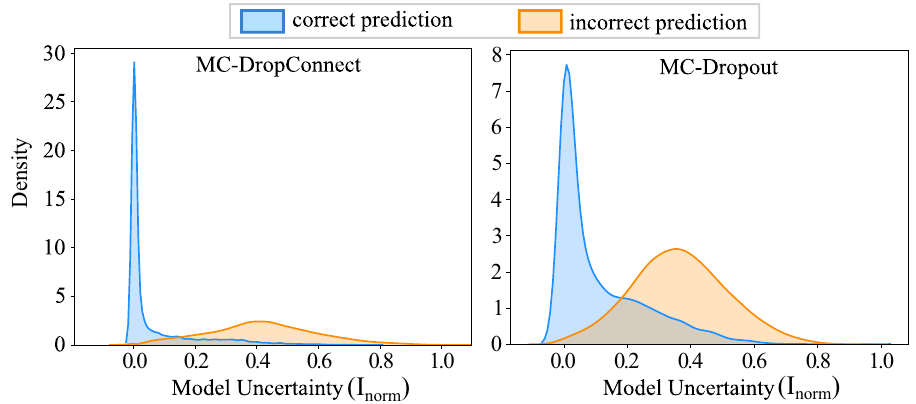
Figure 4. Illustrating the distribution of model uncertainty values for the CIFAR-10 test samples. Distributions are plotted separately for correct and incorrect predictions and for both MC-DropConnect (Left) and MC-Dropout (Right).